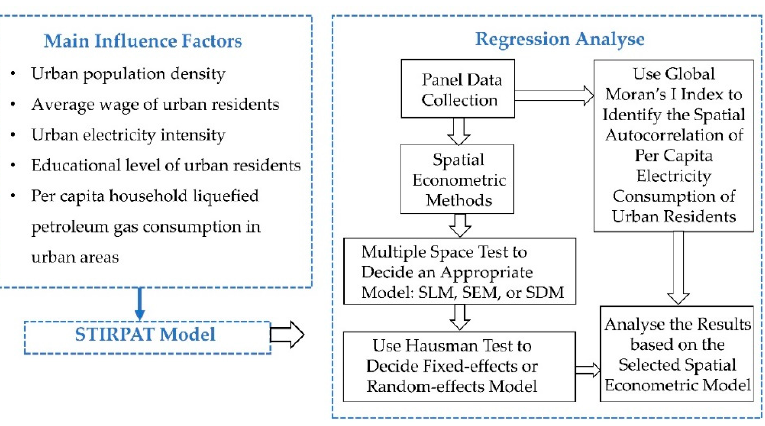
Figure 1. Flowchart of the regression